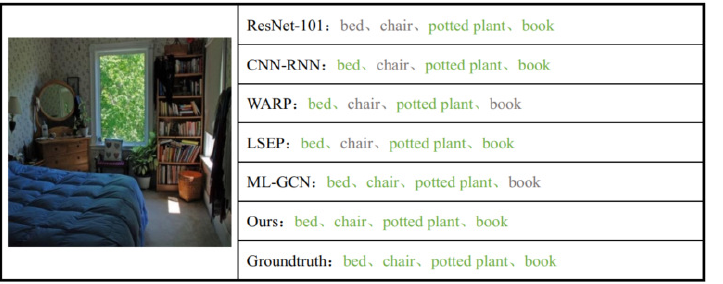
Figure 16. Qualitative results. Example 3.